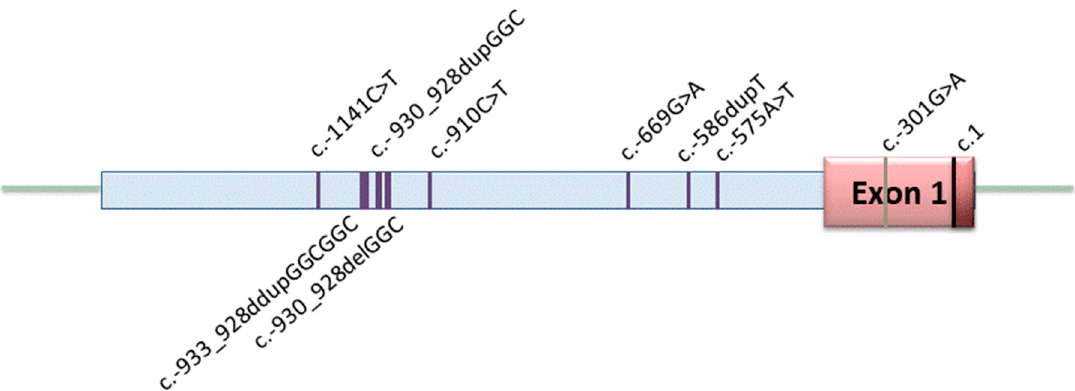
Figure 1. Distribution of variants in the promoter region of BMPR2 . Nine variants were identified including five heterozygous substitutions, three heterozygous duplications/deletions at a single site, and one homozygous substitution (c.-586dupT). The 5 ′ untranslated region starts left of the nucleotide position c.1.